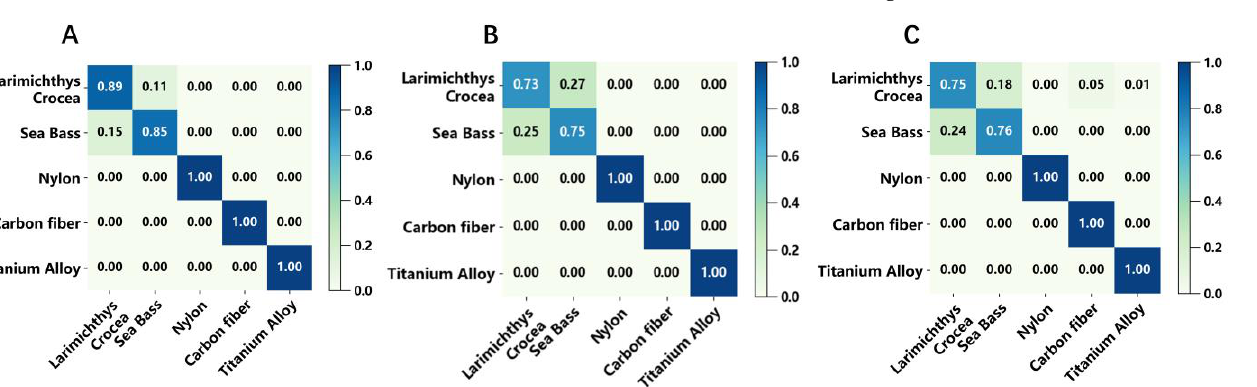
Table 3. Performance of each model in a certain recognition result.